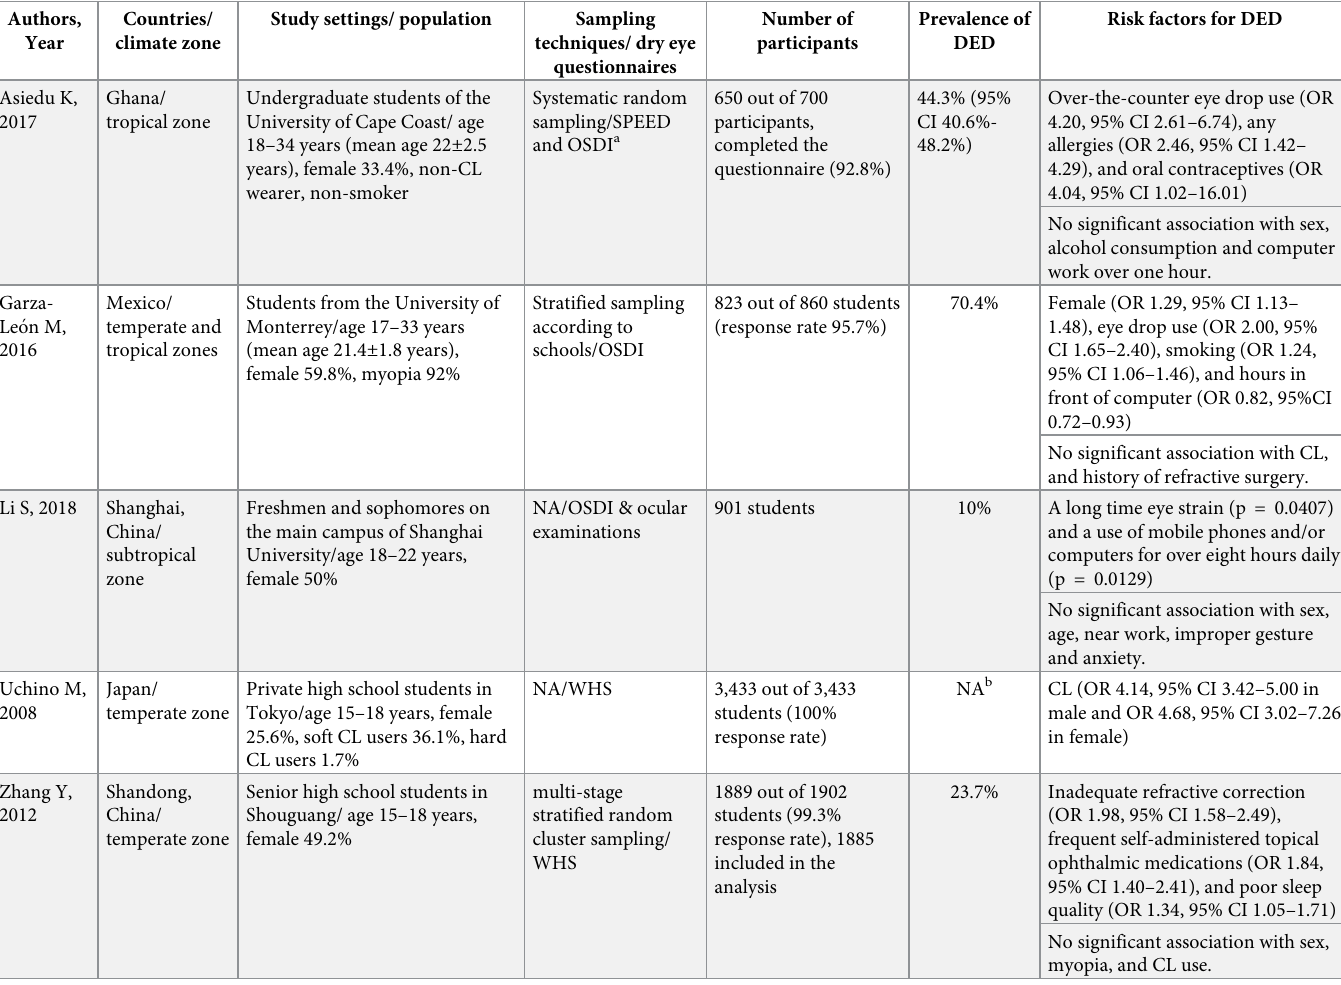
Table 4. A review of dry eye disease prevalence and risk factors in youth population retrieved from Medline database (last update December